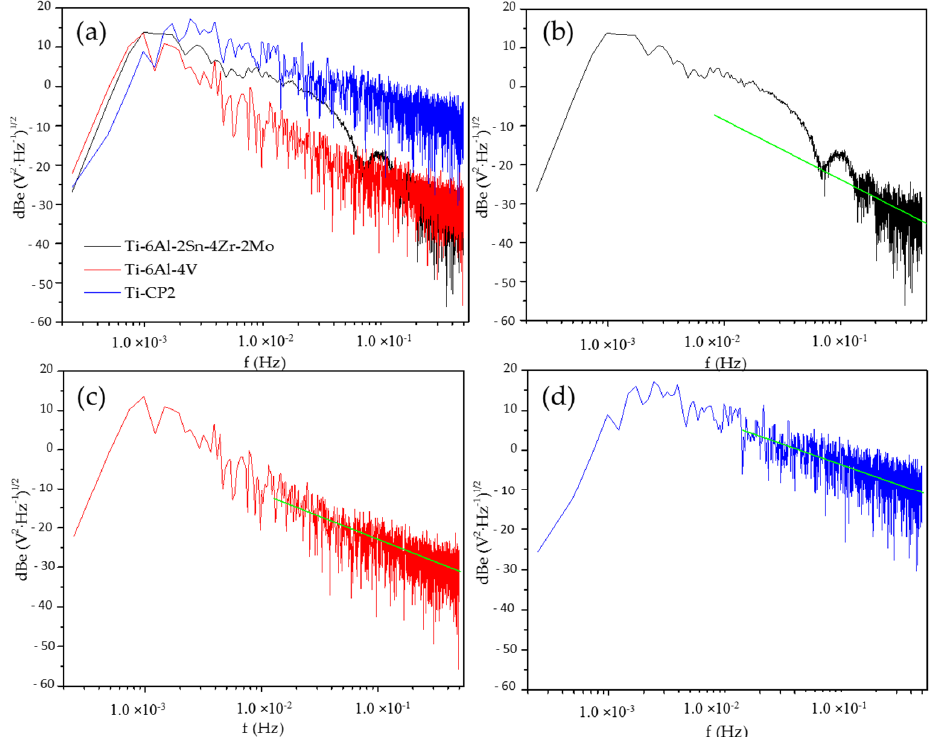
Figure 6. PSD Voltage in H 2 SO 4 ( a ) all samples, ( b ) Ti-6Al-2Sn-4Zr-2Mo, ( c ) Ti-6Al-4V, and ( d ) Ti CP2. Table 4. Parameters obtained by PSD.